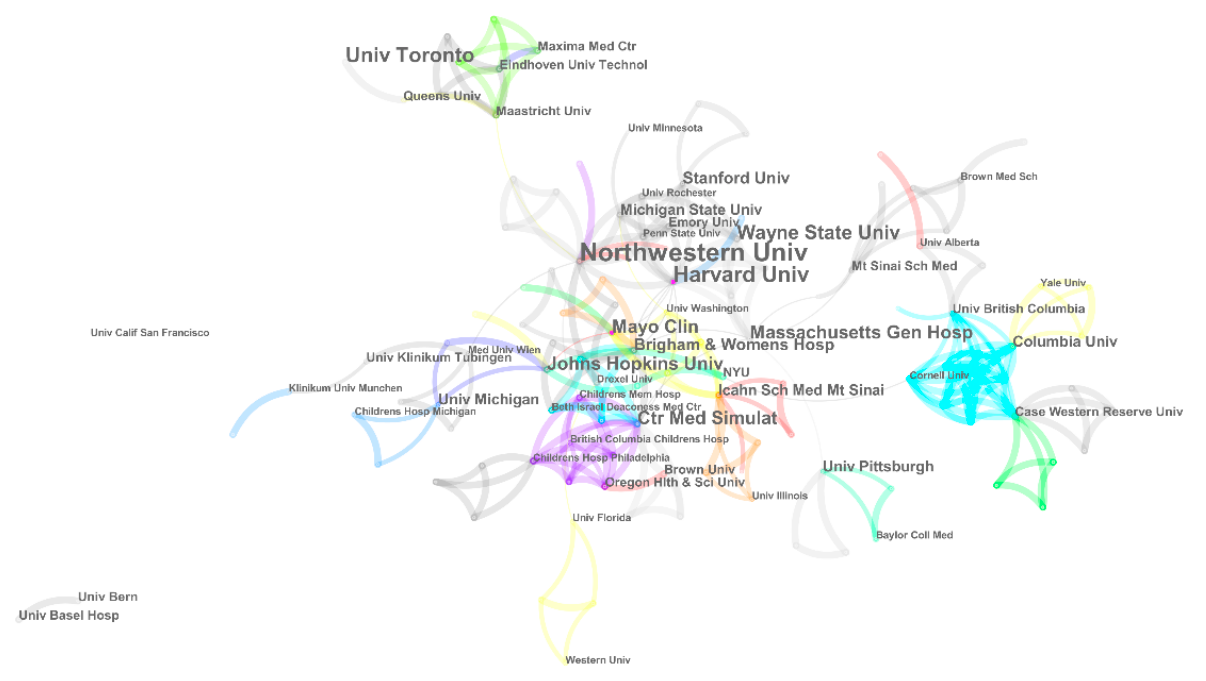
Figure 7. Cluster view of institutional collaborations between 2001 and 2020.